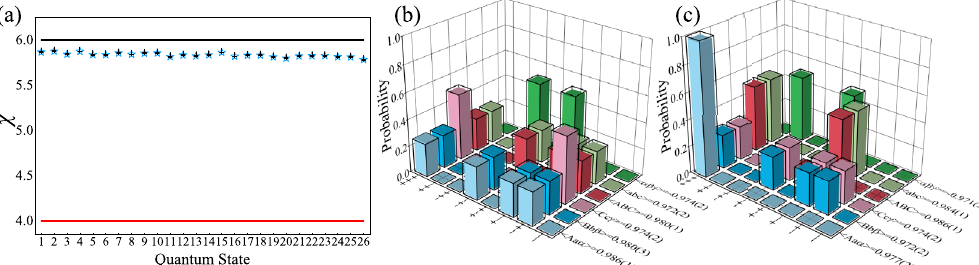
Fig. 2 State-independent violation of the inequality (1). a The value of χ is tested for 26 different quantum states. The red solid line indicates the classical upper bound. Stars indicate the experimental results of χ . Error bars indicate the statistical uncertainty, which is obtained based on assuming Poissonian statistics. Correlation measurements of all terms in the inequality (1) for the states ψ 1 j i ( b ) and ψ 15 j i ( c ). Experimentally estimated probabilities for each sequential measurement of q i . Colored bar at ( + + + ; a i a j a k ) indicates the probability to obtain the results a i = 1, a j = 1, and a k = 1. Theoretical predictions for each set of measurements are shown by the hollow bars.